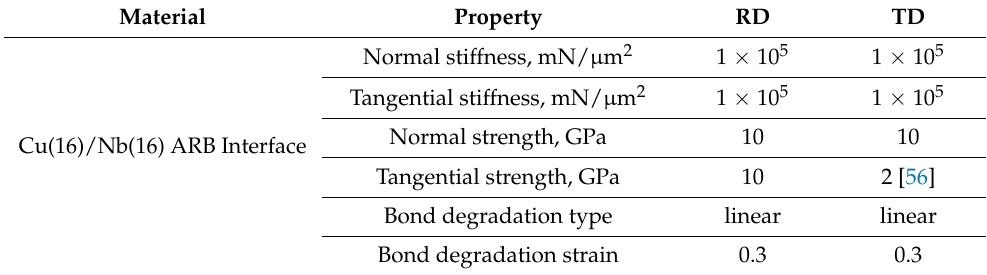
Table 2. The properties of the Cu(16)/Nb(16) ARB interface employed in the nanoindentation